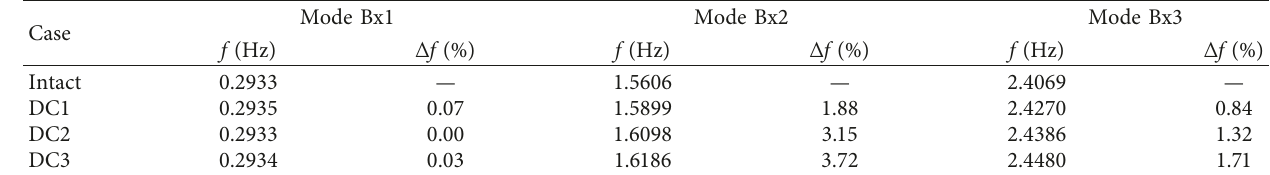
Table 11: Natural frequencies of along-wave bending modes: damage type 2.